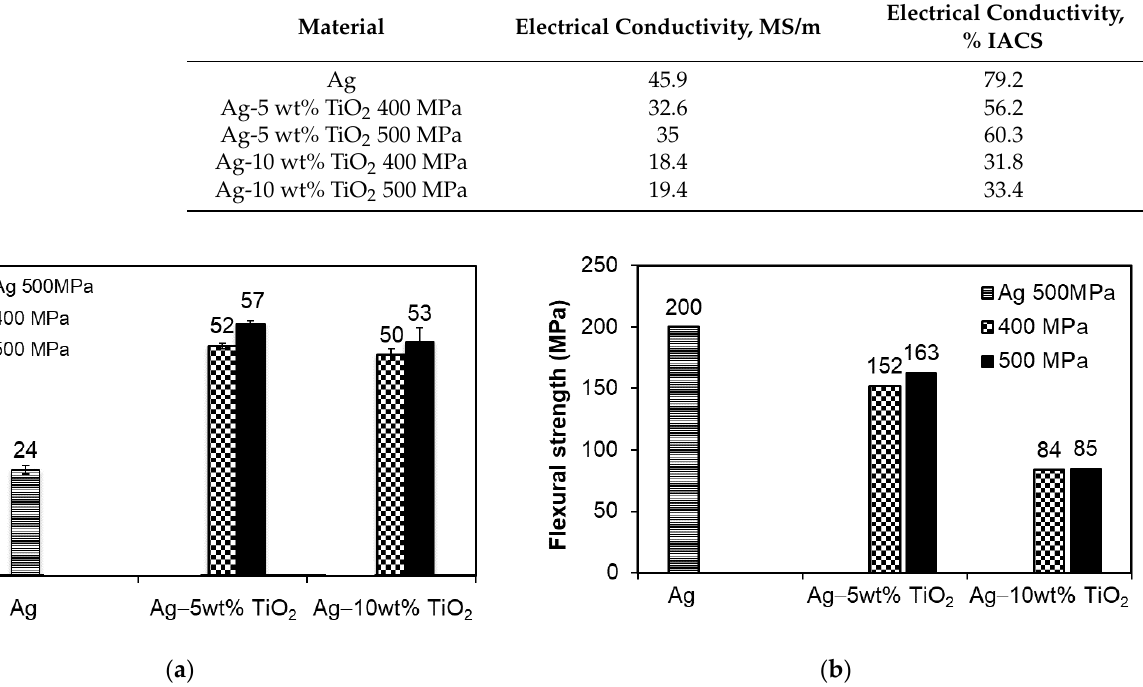
Figure 4. Results of testing composite properties: ( a ) Brinell hardness; ( b ) flexural strength.